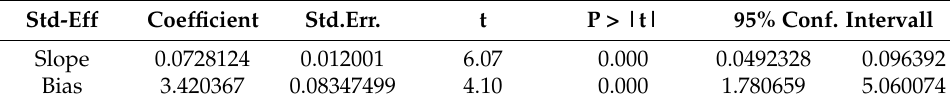
Table A2. Egger’s test results.